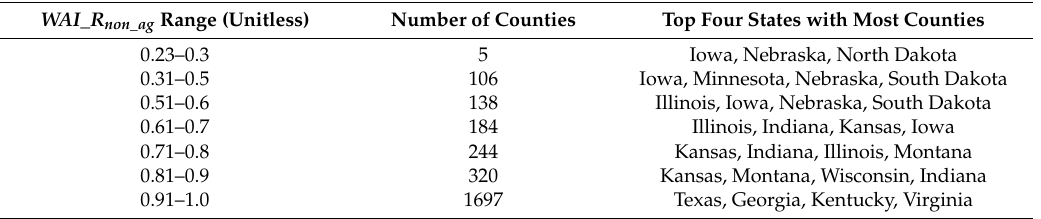
Table 4. Number of counties that fall within each WAI_R non_ag value (dimensionless fractions) band.